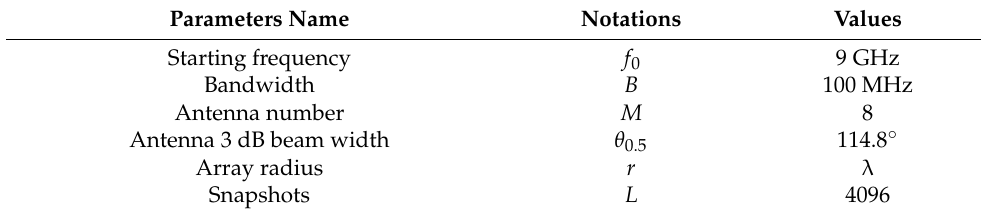
Table 2. Radar parameters in simulation experiments.